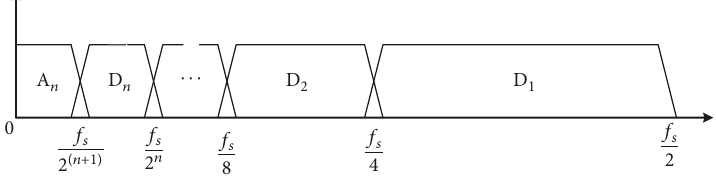
Figure 1: The frequency bands corresponding to the DWT